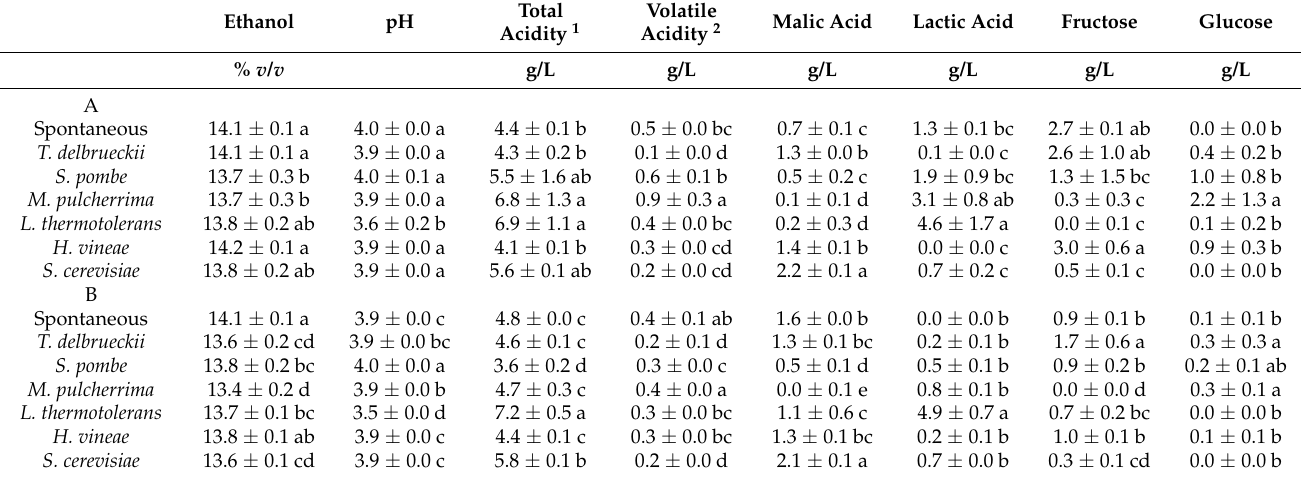
Table 2. Oenological parameters determined with Fourier transform infrared spectroscopy (FTIR) for (A) control fermenta- tions with untreated must and (B) Pulsed light irradiation (PL) treatment. Average and standard deviation (STD) for n = 3. Different letters indicate statistical difference within each treatment p >